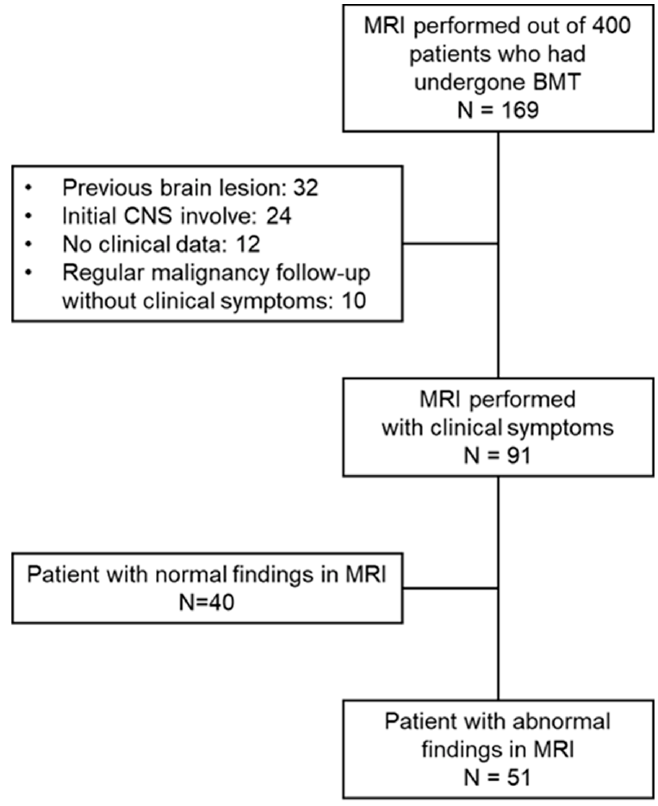
Figure 1. Study scheme .